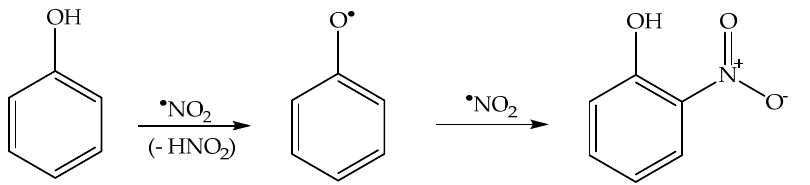
7 of 17 Figure 2. Trends, as a function of pH, of the occurrence of nitrating agents (or of nitration process- es) that are produced (or can be triggered) under irradiation. The following sections provide a number of case studies concerning the photonitra- tion of several aromatic compounds, highlighting the main nitrating agents that are in- volved in the process and, when available, describing the underlying nitration mecha-